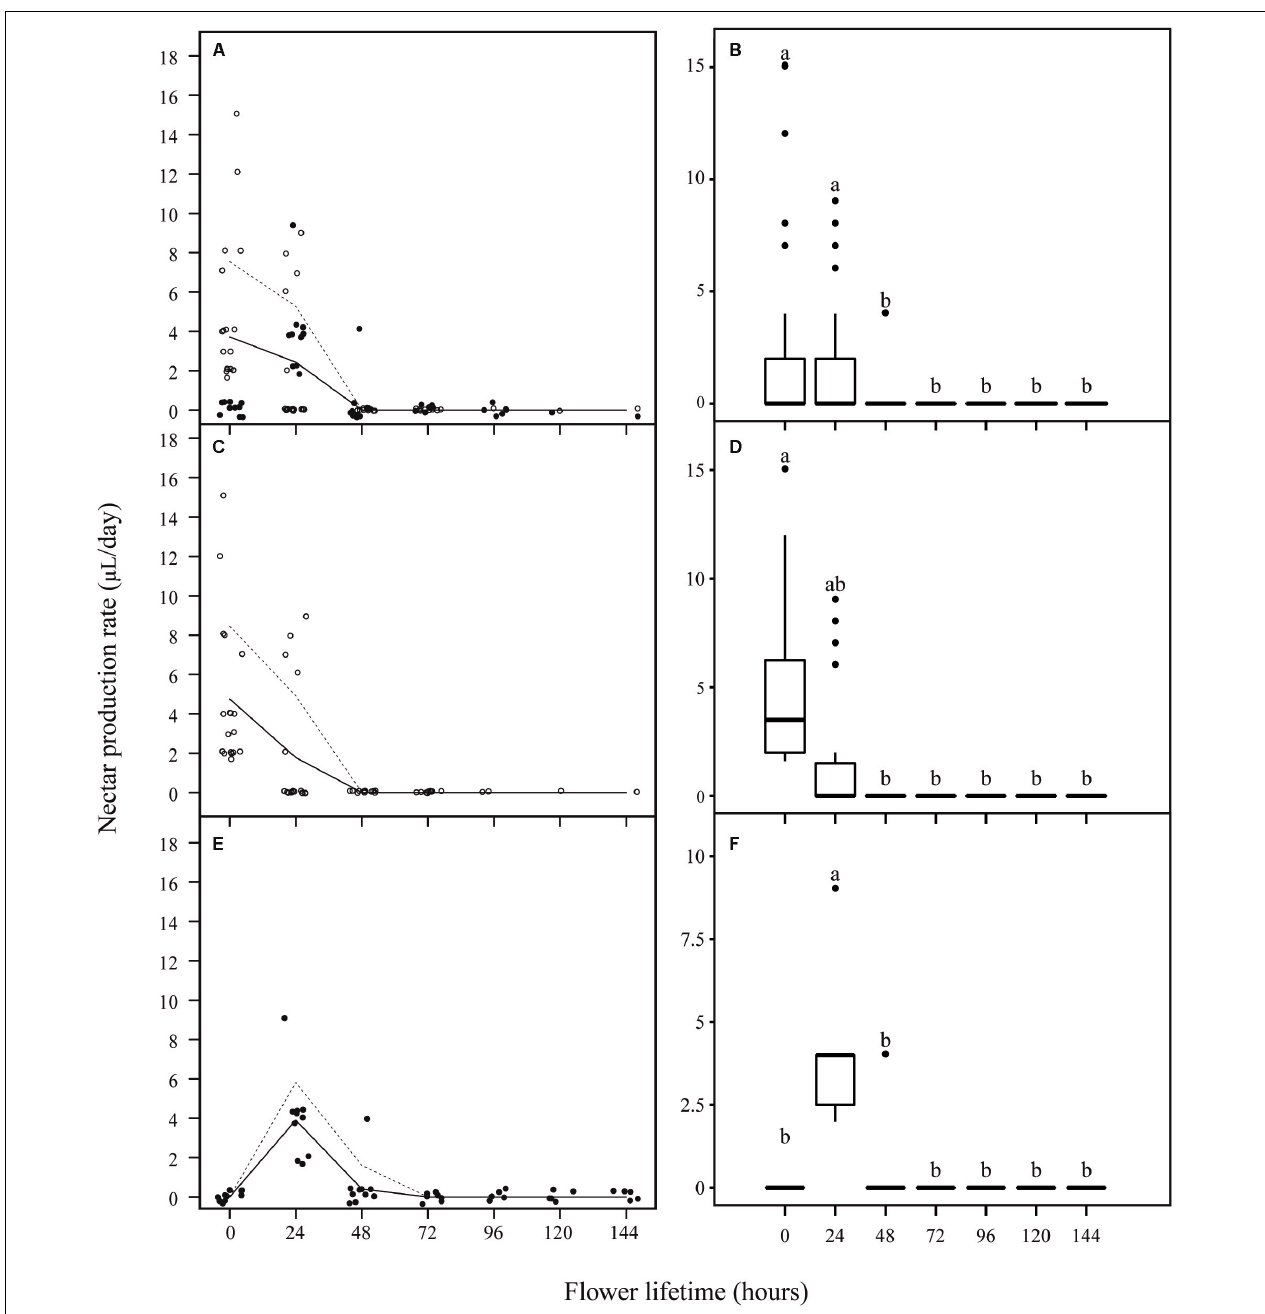
FIGURE 4 | Nectar production rate per flower lifetime in J . oxyphylla flowers. In (A,C,E) , the trendlines describe a visual relationship between the two variables (nectar production rate and flower lifetime) based on the lowest smoother using a locally weighted regression (LOESS). Dashed lines are 95% confidence interval upper limits. The 95% confidence interval lower limits were zero and the line was omitted. The empty circles represent ‘early’ flowers and the full circles represent ‘late’ flowers. In (B,D,F) , the box plots show the median (horizontal line across the box), 25th and 75th percentiles (lower and upper edges of the box) and the upper and lower whiskers, which correspond to the higher and lower data that is no further from the box than 1.5 times the interquartile range. Any data that lied beyond the whiskers was considered an outlier (filled circles). Nectar production rates significantly different from one period to another are denoted by different letters above the boxes (ANOVA with Brown–Forsythe correction for heteroskedastic data and Games–Howell post hoc test). (A) Nectar production rate per flower at every 24 h of anthesis. (B) Nectar production rate was similar during the first 2 days of anthesis, followed by an undermost production during the third day of anthesis and ceasing before 72 h of anthesis ( p < 0.05); (C) nectar production rate per ‘early’ flowers at every 24 h of anthesis; (D) in ‘early’ flowers, the maximum volume of nectar occurred at 0 h, followed by the addition of smaller amounts of nectar until 24 h and by production cessation ( p < 0.05); (E) nectar production rate per ‘late’ flowers at every 24 h of anthesis; (F) in ‘late’ flowers, the maximum volume of nectar registered at 24 h, followed by a smaller production until 48 h and by production cessation ( p < 0.05).